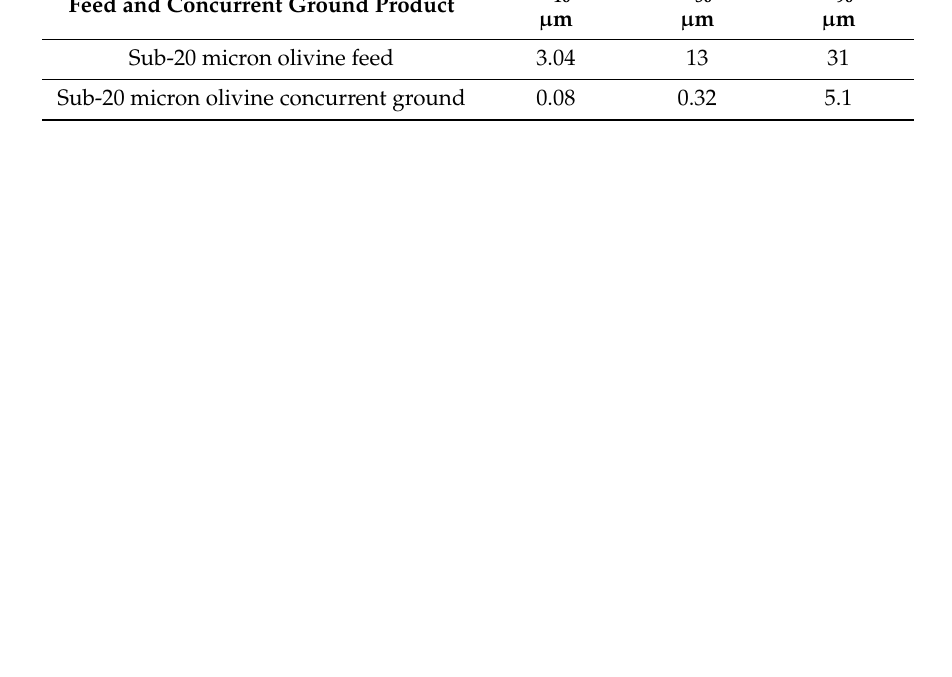
Figure 12. Mg extraction for sub-20 micron olivine ( left ), PSD analysis for sub-20 micron olivine feed and concurrent ground product ( right ).